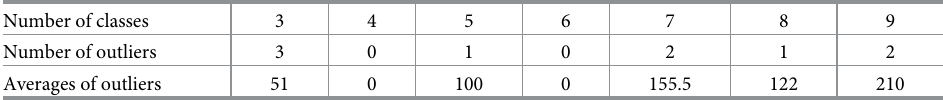
Table 4. The results of experiments that varied the number of classes from three to nine, showing the number of outliers—the number of trials out of 30 that did not yield a unique solution. Row two shows the average number of solutions found in those outliers. The results indicate that a partitioning into either 4 or 6 classes is most likely to pro- duce a unique